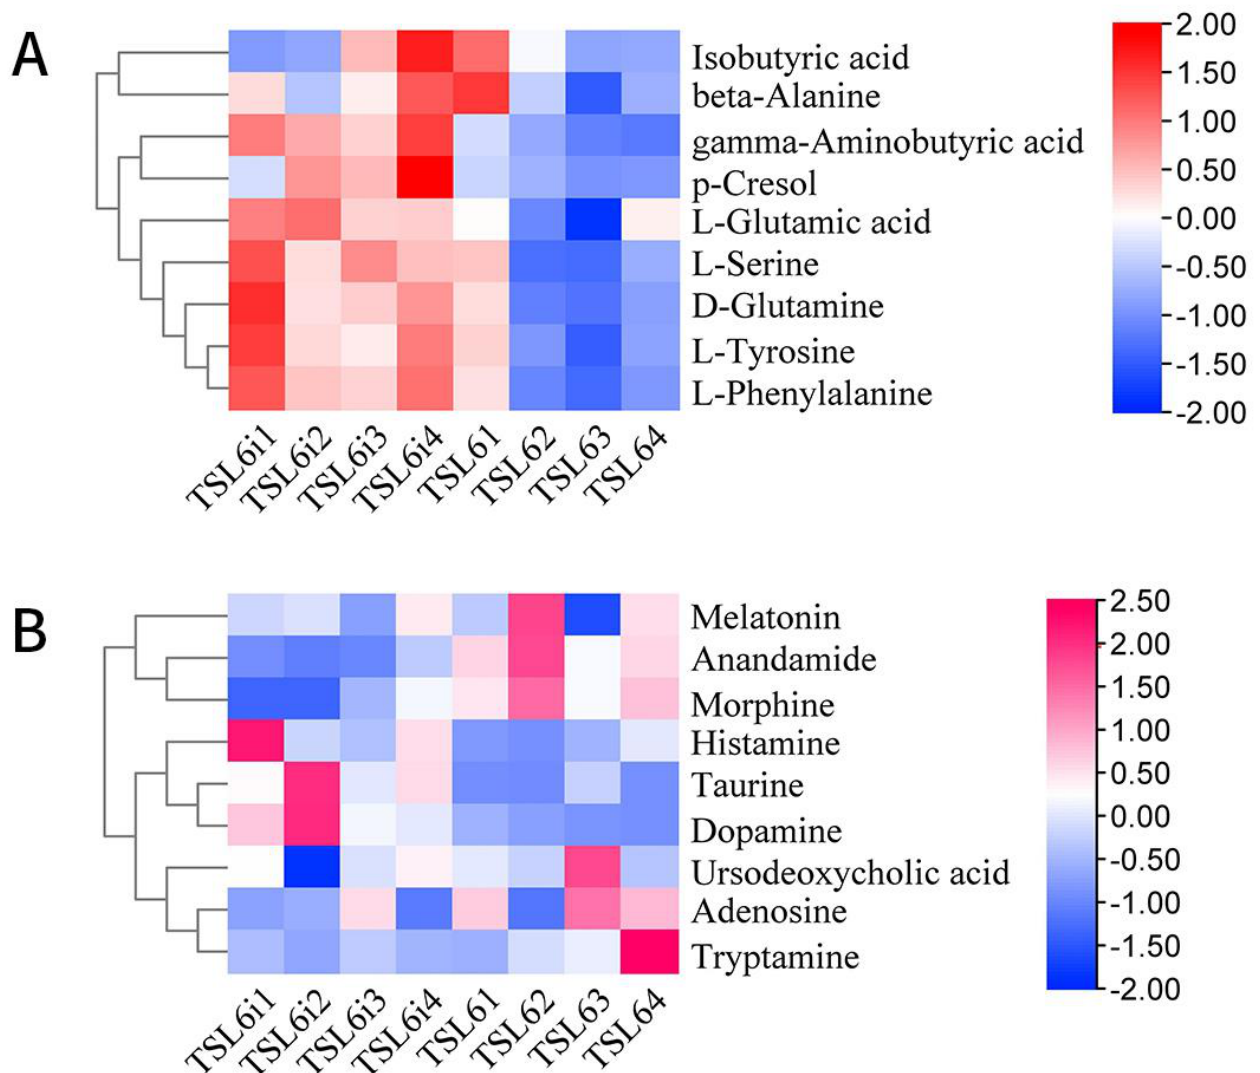
Figure 7. Analysis of differential metabolites in mice before and after intervention with LZU − J − TSL6 . Chromatographic cluster analysis of differential metabolites before ( A ) and ( B ) after LZU − J − TSL6 intervention (a negative ion mode, b positive ion mode).